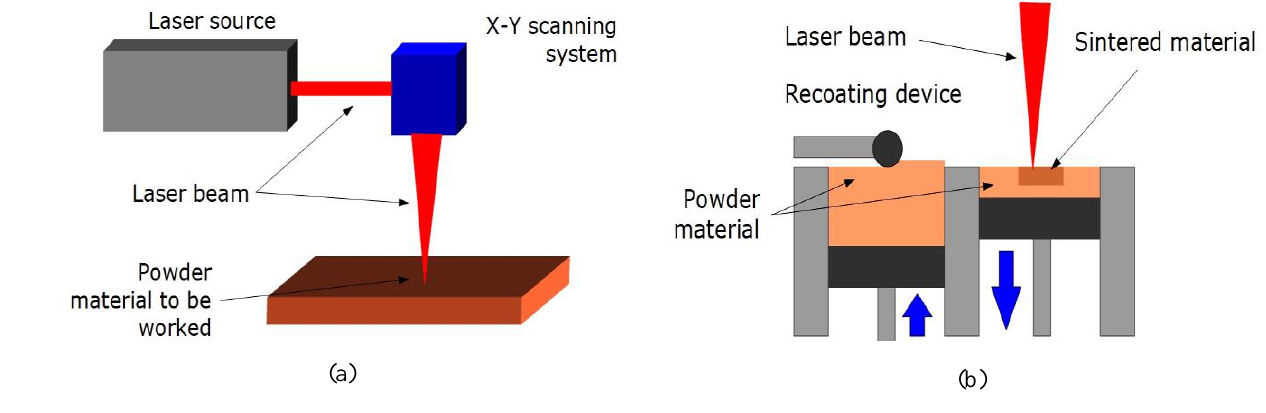
Figure 1. Conceptual scheme of a